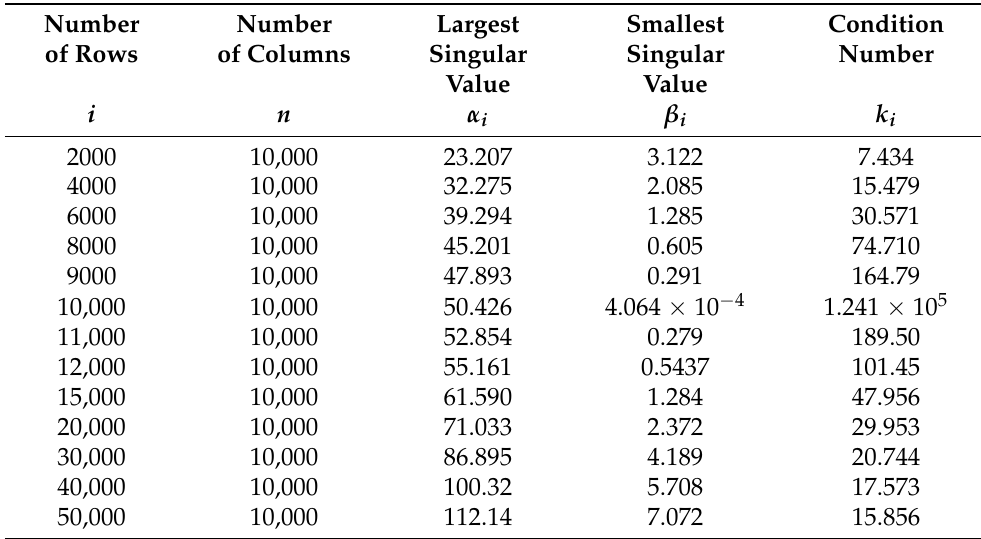
Table 11. The anomaly in large sparse random